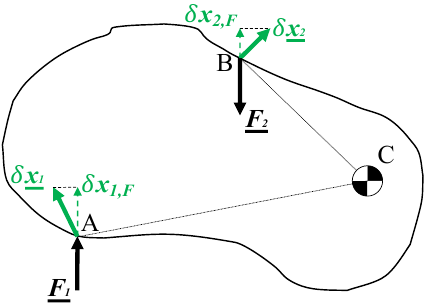
Figure 7. Generic rigid body with forces applied at points A and